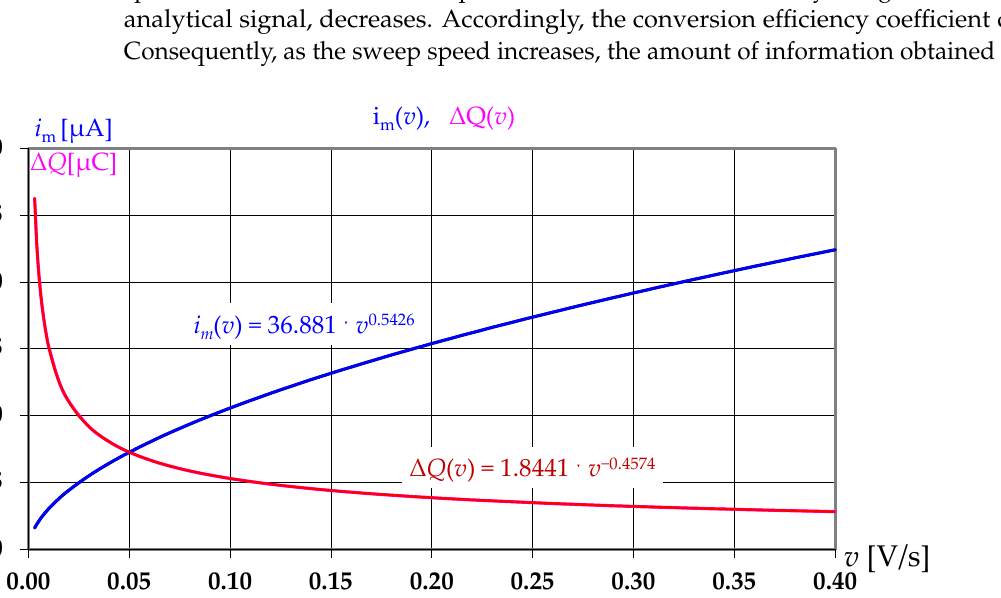
Figure 2. Graphs of the dependence of the amplitude of the current peak (13) and the Faraday charge flowing through the working electrode (17).